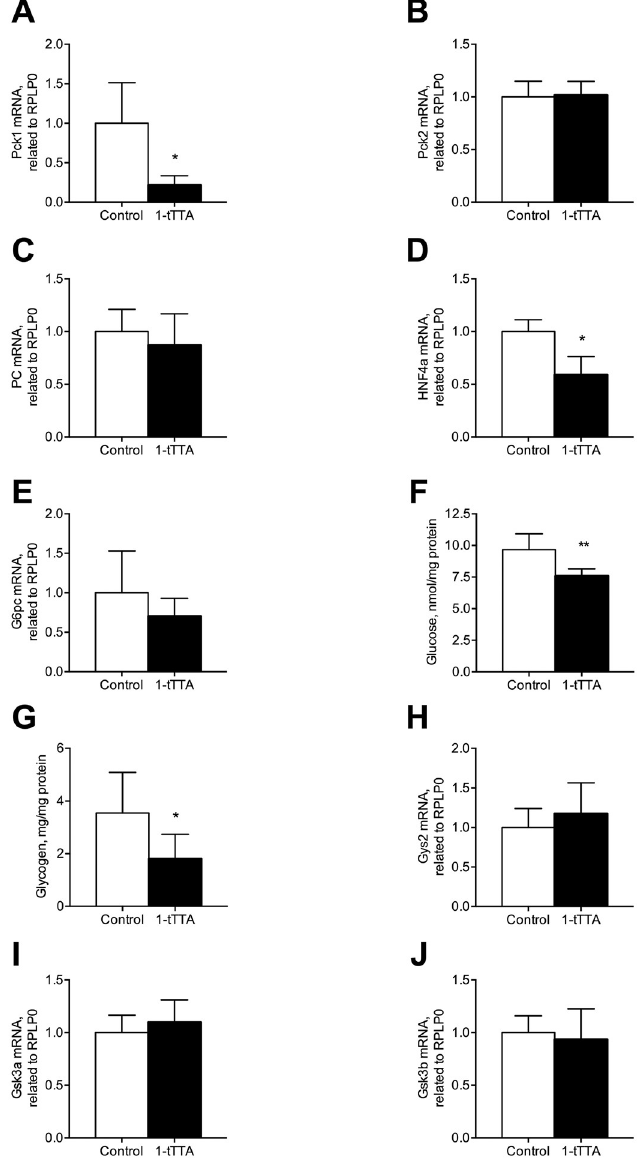
Fig 5. Hepatic glucose and glycogen levels, and mRNA levels of enzymes involved in gluconeogenesis and glycogen synthesis after 3 weeks treatment with vehicle (control) or 1-triple TTA (1-tTTA) in rats. ( a ) Phosphoenolpyruvate carboxykinase, cytosolic (PEPCK-C/ Pck1 ) mRNA level, ( b ) phosphoenolpyruvate carboxykinase-mitochondrial (PEPCK-M/ Pck2 ) mRNA level, ( c ) pyruvate carboxylase ( Pc ) mRNA level, ( d ) hepatocyte nuclear factor 4a ( Hnf4a ) mRNA level, ( e ) glucose-6 phosphatase ( G6pc ) mRNA level, ( f ) the hepatic glucose level, ( g ) the hepatic glycogen level, ( h ) glycogen synthetase 2 ( Gys2 ) mRNA level, ( i ) Gys3a mRNA level, ( j ) glycogen synthetase 3 beta ( Gsk3b ) mRNA level. Gene expression levels were normalized to the house keeping gene RPLP0 and relative values are given. All values shown are means with standard deviation (n = 6–8). Statistically significant differences between means were determined using Students t-test, � p < 0.05 vs. control. different hormones at the transcription level. Accordingly, suppression of PEPCK gene expression ( Pck1 and Pck2 ) is a potential target for mitochondrial proliferating antidiabetic drugs. Administration of 1-triple TTA strongly decreased gene expression of Pck1 , whereas the mRNA level of Pck2 remained unaltered compared to control animals. A role for